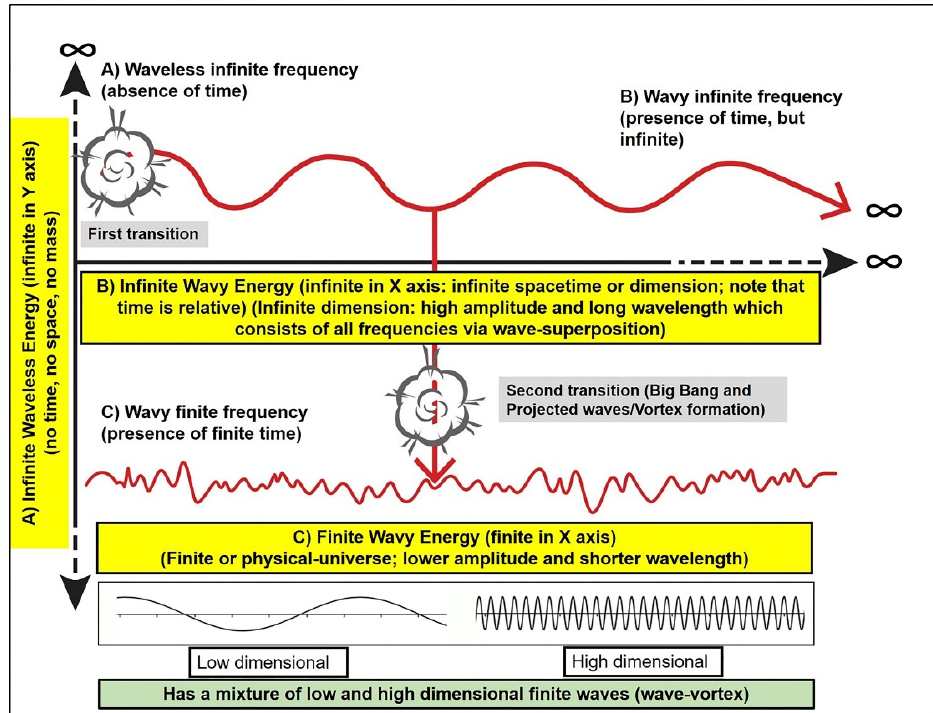
Figure 1. The two transitional points of the universe. The first transition is at the point between waveless ( A ) and wavy infinite energy ( B ). The second transition (the singularity or origin of our universe) is at the point between wavy infinite energy ( B ) and wavy finite energy ( C ), which has a mixture of various wave patterns—low, high, and intermediate dimensional waves. Thus, infinite energy, infinite light, or infinite frequency (the highest light and all light) may have already existed before the singularity, and the origin of lower light could have been from higher light.